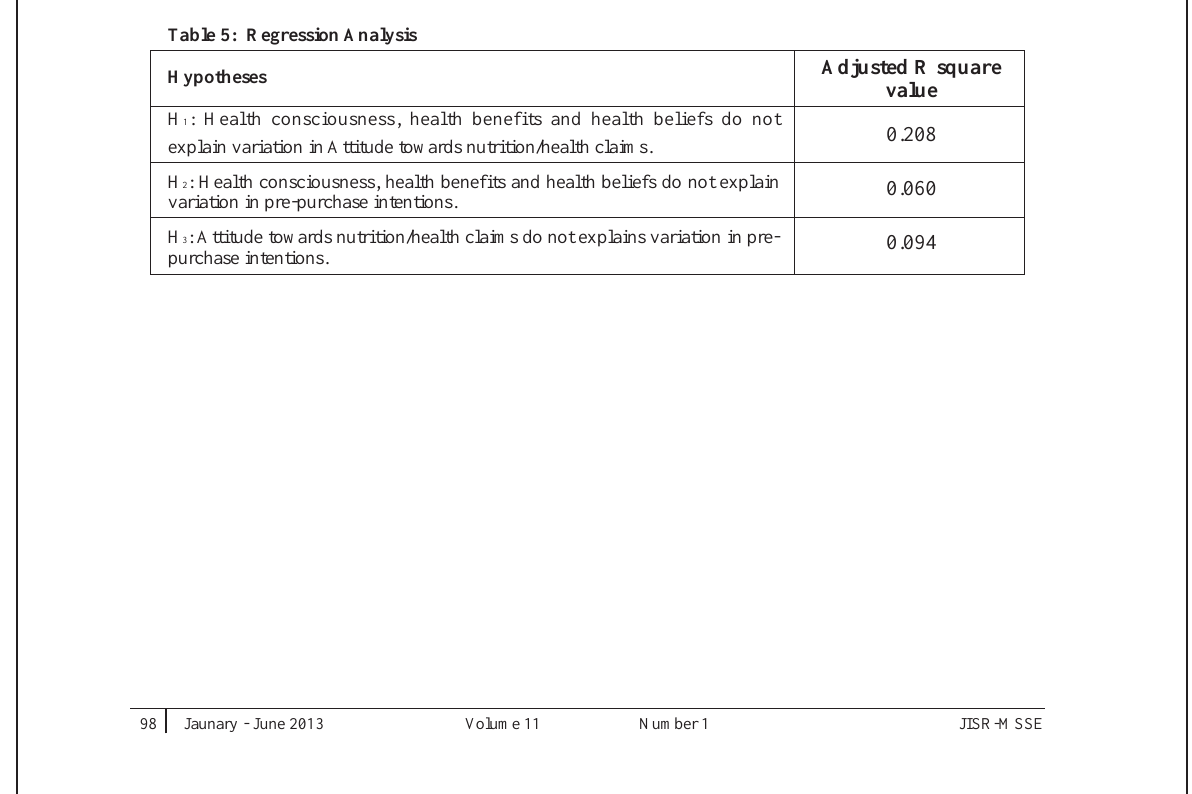
Table 5: Regression Analysis